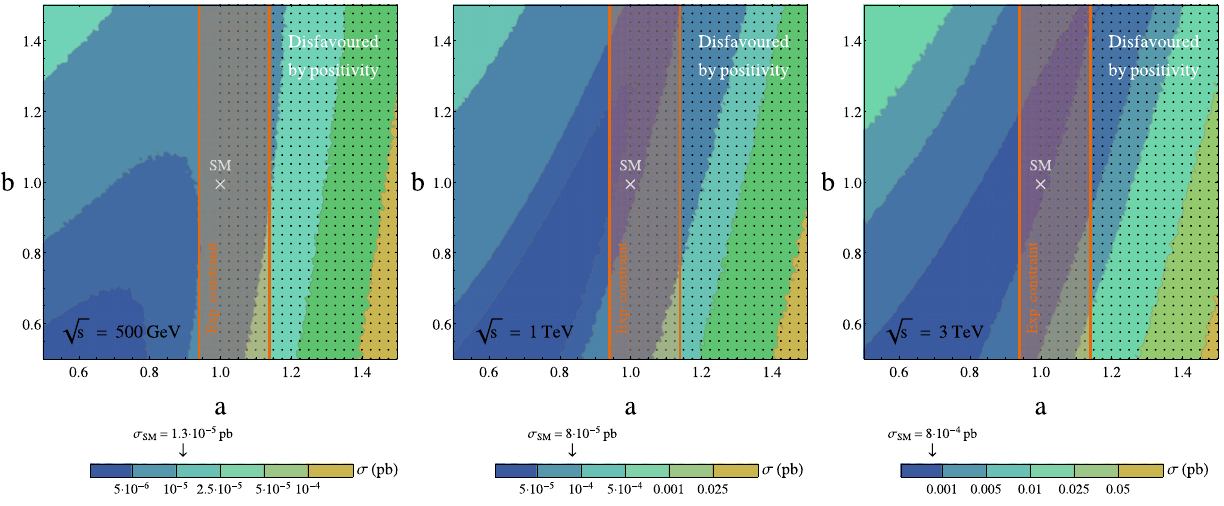
Fig. 20 EChL predictions for contour lines of σ( e + e − → H H ν e ¯ ν e ) (in pb) in the ( a , b ) parameter space, at a CM energy of 500 GeV (left panel), 1 TeV (middle panel) and 3 TeV (right panel). The dotted region